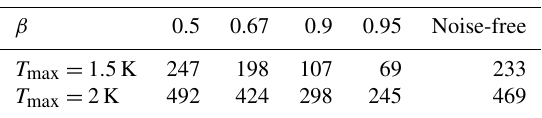
Figure 4. The safe carbon budget. (cid:49)T max in 2100 such that p ( (cid:49)T 2100 ≤ (cid:49)T max ) = β as a function of cumulative emissions for different β . The black curve gives the deterministic results with noise terms in the stochastic model set to zero. Table 3. Safe Carbon Budget (inGtC since 2015) as a function of threshold and safety probability β